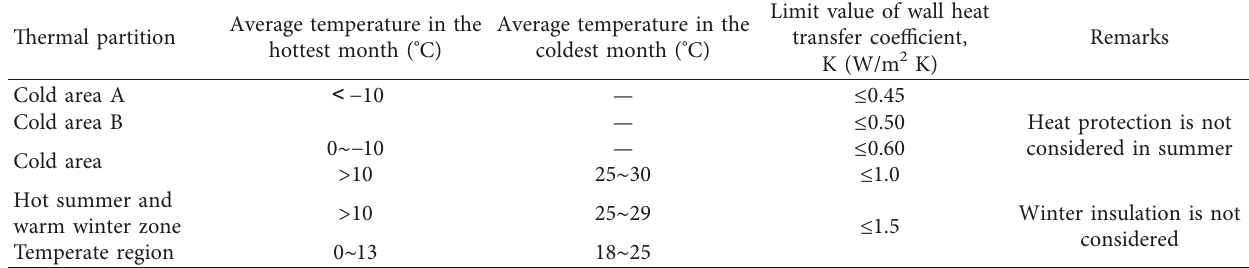
Table 1: Limits of building thermal zoning and wall heat transfer coefficient in China.